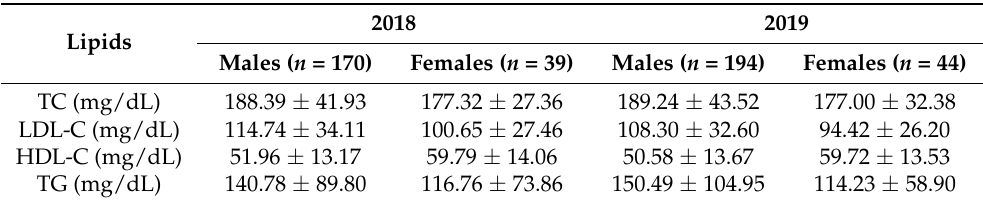
Table 3. Descriptive data (mean ± SD) for total cholesterol (TC), low-density lipoproteins (LDL-C), high-density lipoproteins (HDL-C), and triglycerides (TG) in male and female police officers from health and wellness programs in 2018 and 2019. All lipid levels are measured in milligrams per deciliter